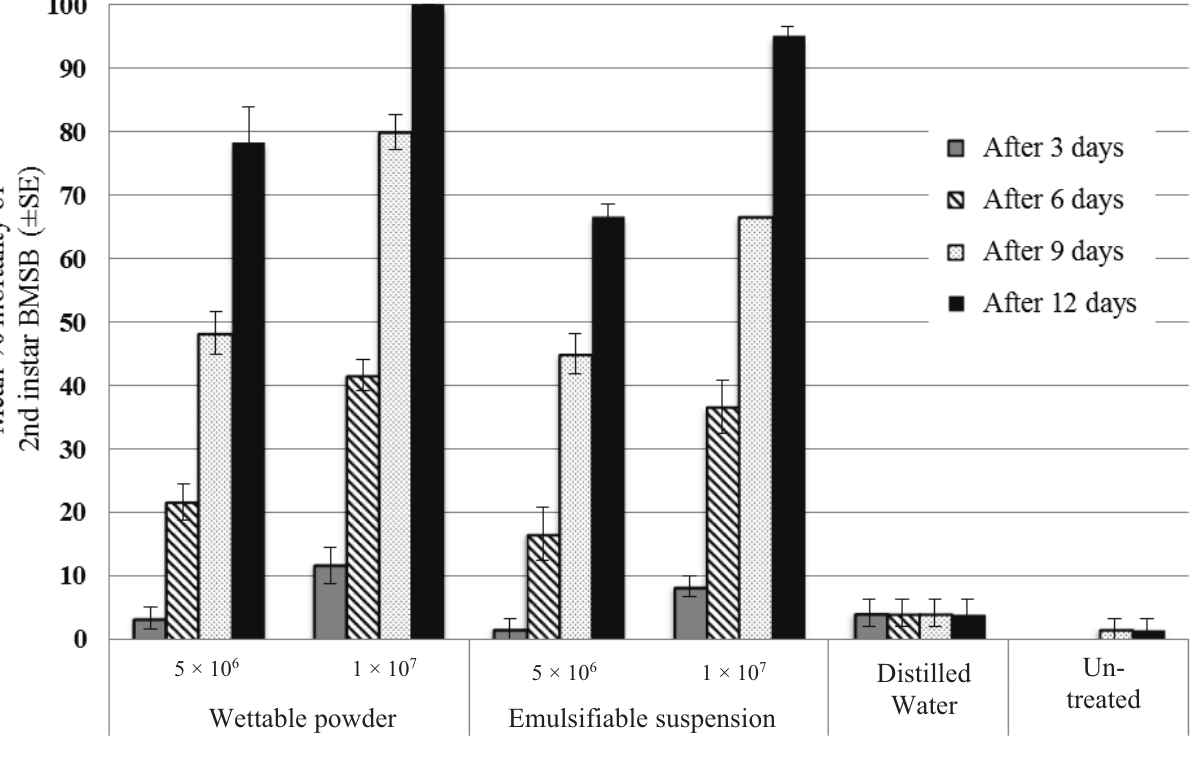
Figure 1. Mean percent mortality (± SE) of brown marmorated stink bug (BMSB) nymphs at 3, 6, 9 and 12 days after treatment with two concentrations of BotaniGard ® ES